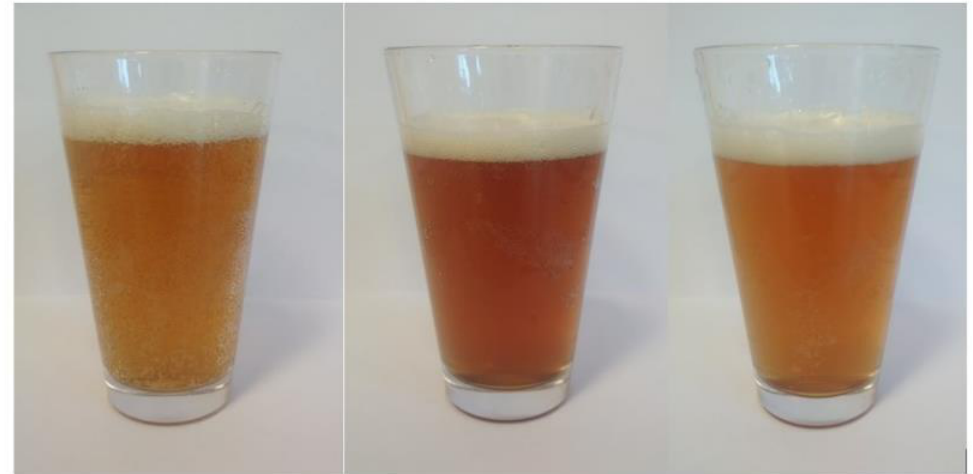
Figure 3. The appearance of the obtained barley beers with addition of the Saskatoon fruits. From left: CB—control, MB0—cv. ‘Martin’ with ozone-treated fruit and MB1—untreated fruit.